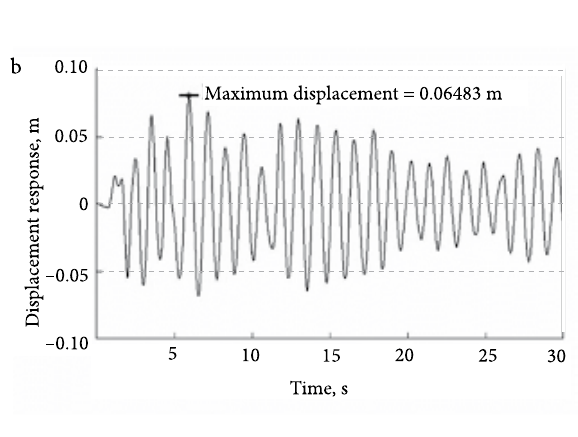
Fig. 9. POT (a), RB (b) and LRB (c) of capacity